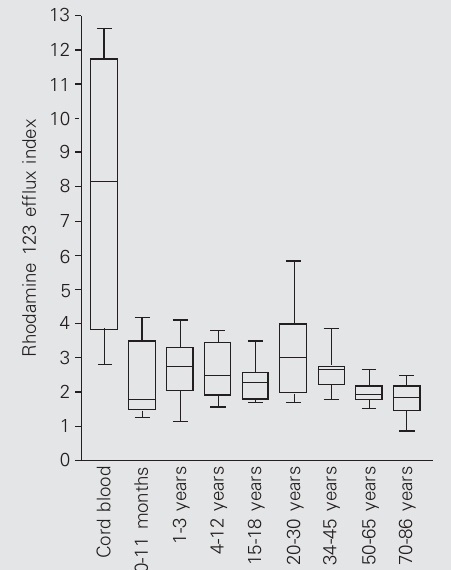
Figure 1. Variation of P-glyco- protein function in T CD4+ lym- phocytes with age. P-glycopro- tein function is reported as the ratio of rhodamine 123 mean fluorescence in the presence and in the absence of verapamil (rhodamine 123 efflux index). P- glycoprotein functional expres- sion was highest in cord blood, progressively decreasing with age and reaching the lowest lev- els in the 70- to 86-year group.